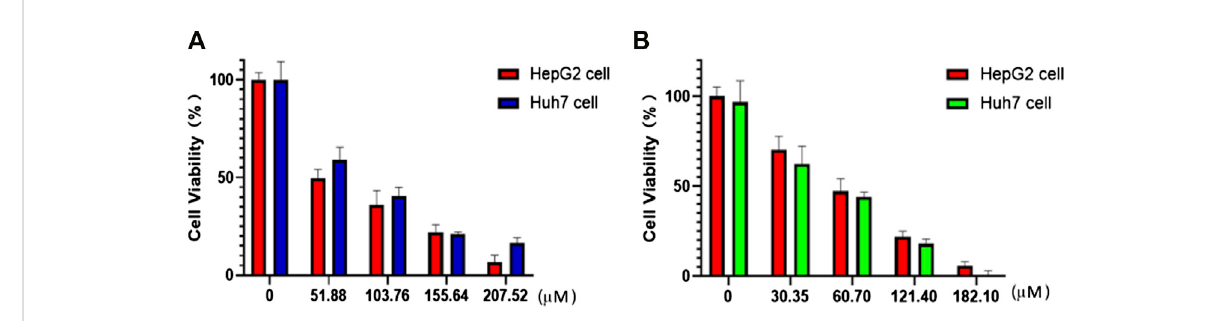
FIGURE 4 In vitro CCK8 assay of HepG2 and Huh7 cells treated with (A) compound 1 NPs and (B) compound 2 NPs.